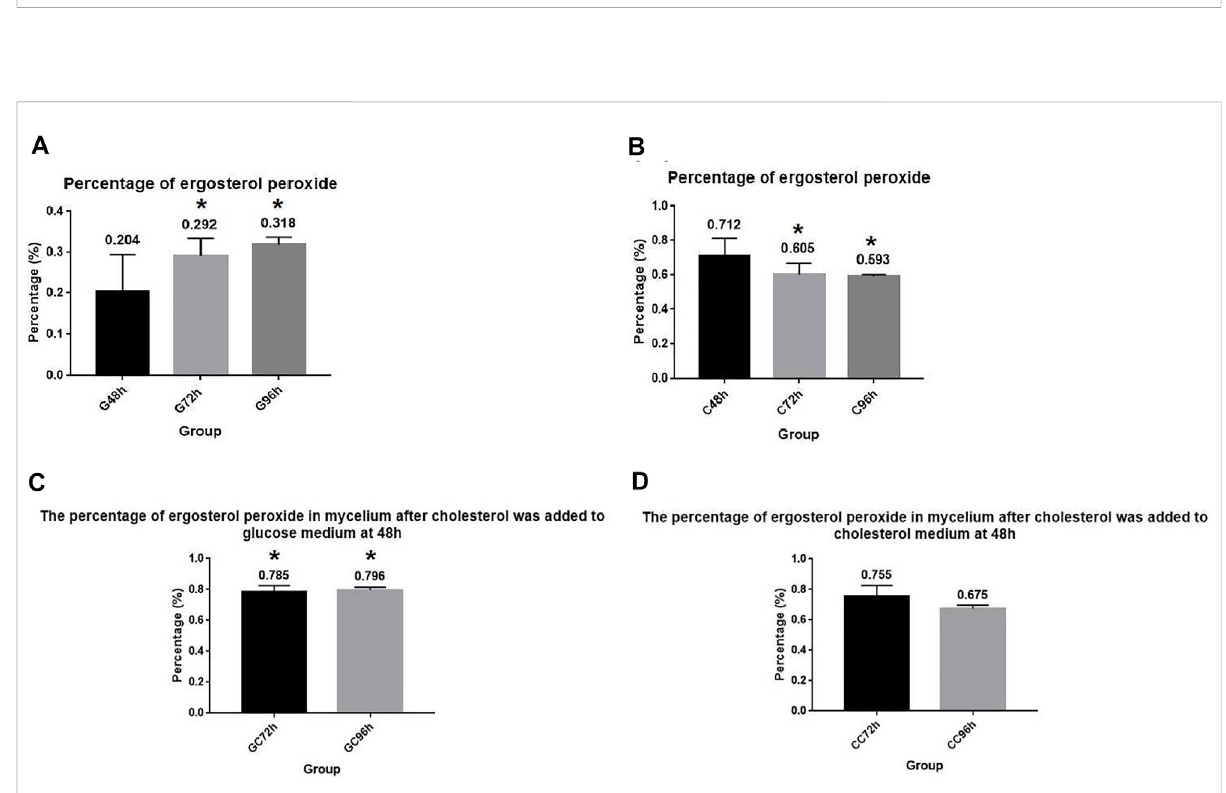
FIGURE 3 A.oryzae canpromotethesynthesisofergosterolperoxidebyutilizingcholesterol. (A) Normalglucosemediumfermentedby A.oryzae ,andthe percentageof ergosterolperoxide inmycelium dry weight at 48, 72, and 96 hwas determined. (B) Cholesterol medium was fermented by A.oryzae , and the percentage of ergosterol peroxide in mycelium dry weight at 48, 72, and 96 h was determined. (C) Normal glucose medium was fermented by A.oryzae ,andcholesterolwasaddedtothemediumagainat48 h.Thepercentageofergosterolperoxideinthemyceliumdryweightat72 h and 96 h. (D) Cholesterol medium was fermented by A. oryzae , and the same amount of cholesterol was added to the medium again at 48 h. The percentage of ergosterol peroxide in the mycelium dry weight at 72 h and 96 h. Three independent experiments were performed. The asterisk denotes statistically signi fi cant differences between the (A) and (B) , and (A) and (C) at 72 h or 96 h based on Student ’ s t -tests (* p <